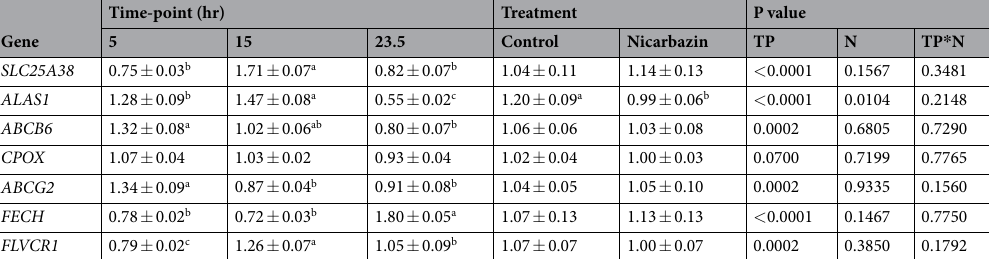
Table 2. Relative expression levels of candidate target genes involved in the synthesis of protoporphyrin IX and/ or heme at different time-points of eggshell formation in the shell gland of laying hens treated with nicarbazin. The time-point and nicarbazin treatment columns show main effects on the expression levels of the genes. Values are the mean of normalized relative quantities (NRQ) ± standard error. Relative quantities for individual gene are scaled to the average across all unknown samples per target gene. Within each treatment, different superscript letters a,b,c across a row denote significantly different results. TP is time-point, while N denotes nicarbazin treatment.